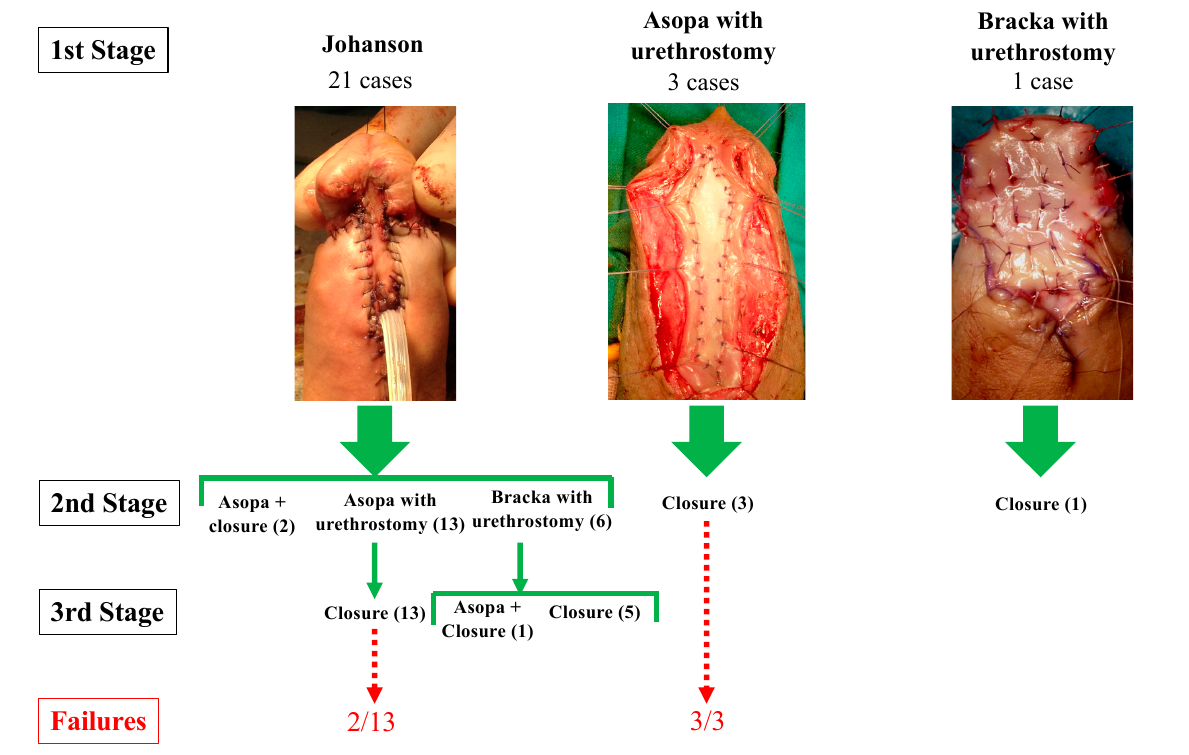
Figure 1. The figure summarizes the surgical management of the patients enrolled in the study with available follow-up. In brackets is reported the number of patients who underwent the procedure, and in red is the number of patients where the treatment failed.